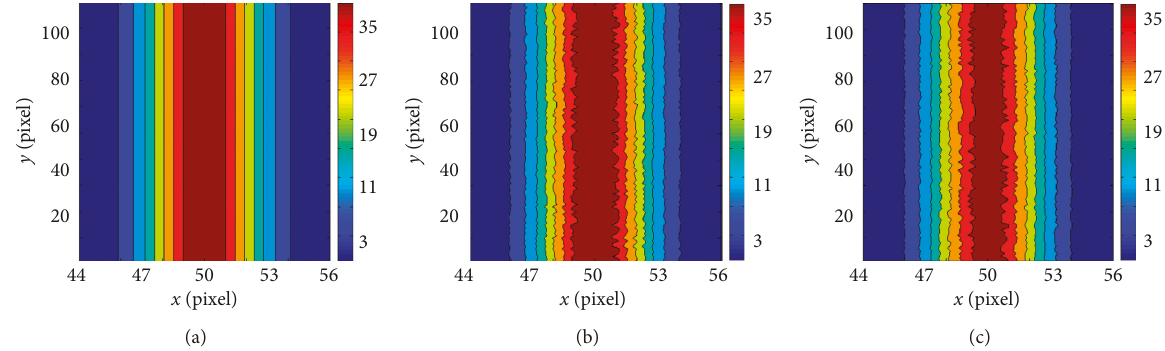
Figure 8: Inhomogeneous deformation field obtained different algorithms. (a) Deformation theory. (b) CTSFA. (c) SFA.